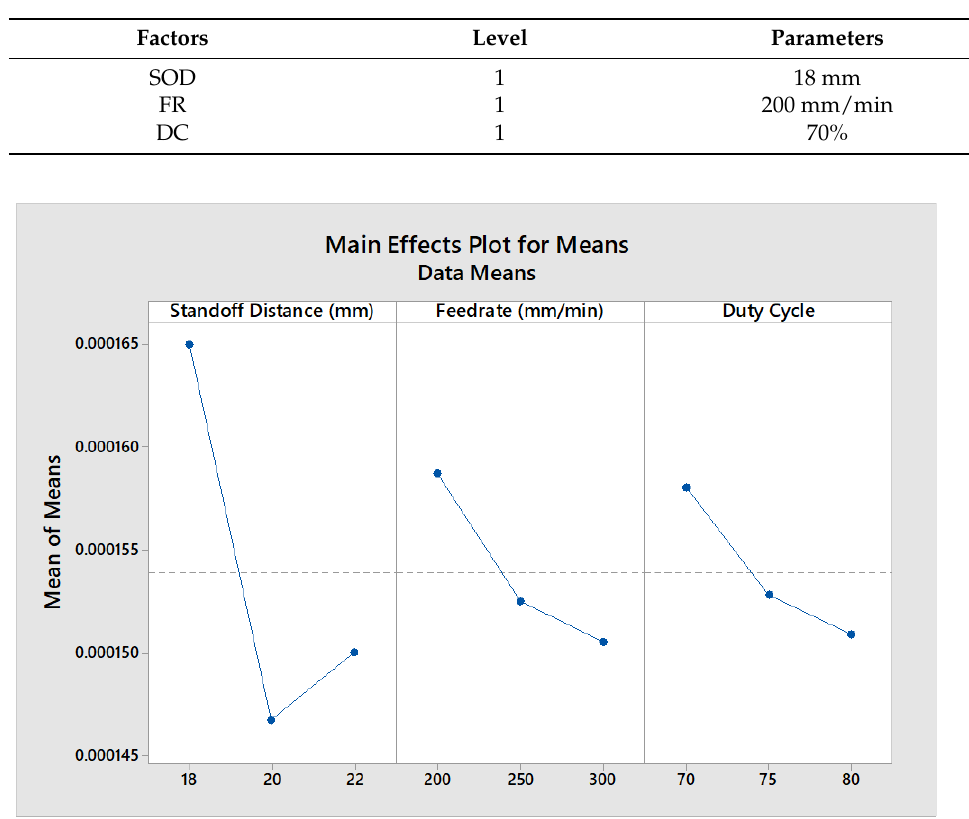
Figure 10. MEP of process factors on MRPI. Table 5. Computation of optimal parameter combination.